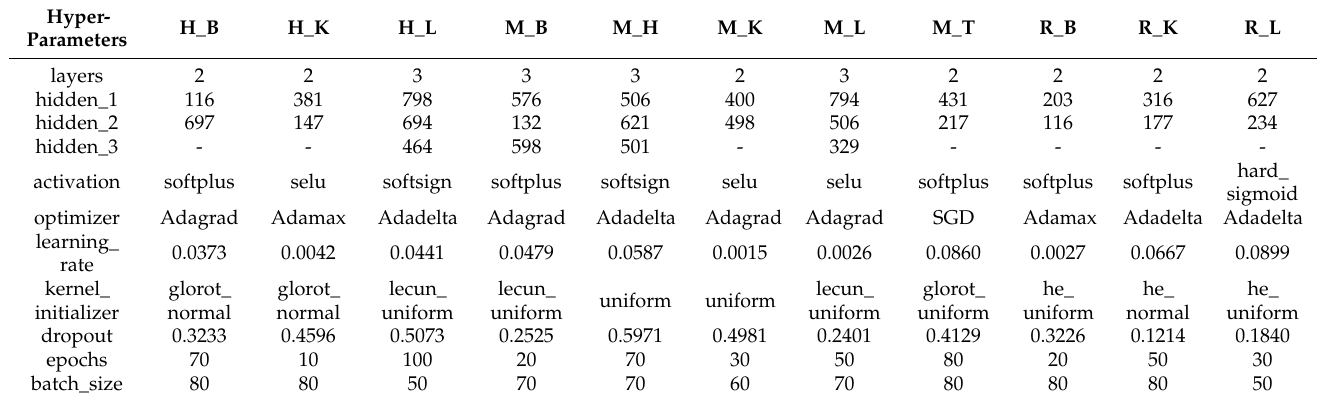
Table 4. The optimization results of the